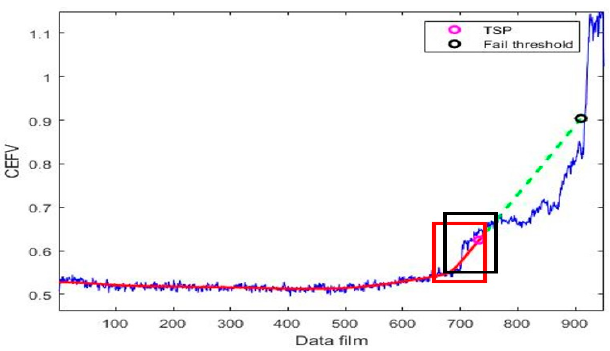
Figure 9. Polynomial regression prediction diagram.